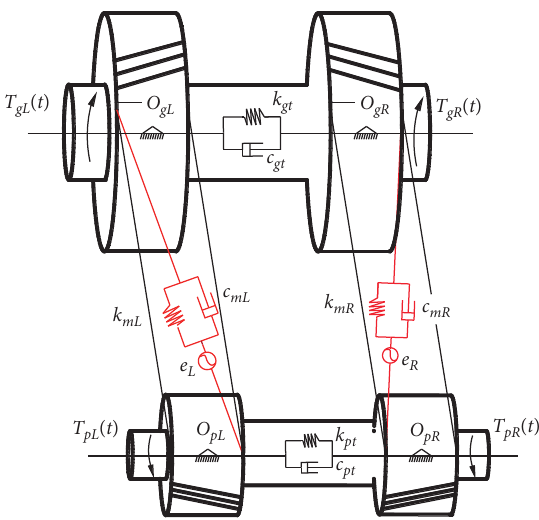
Figure 1: Torsional nonlinear dynamic model of double-helical gear